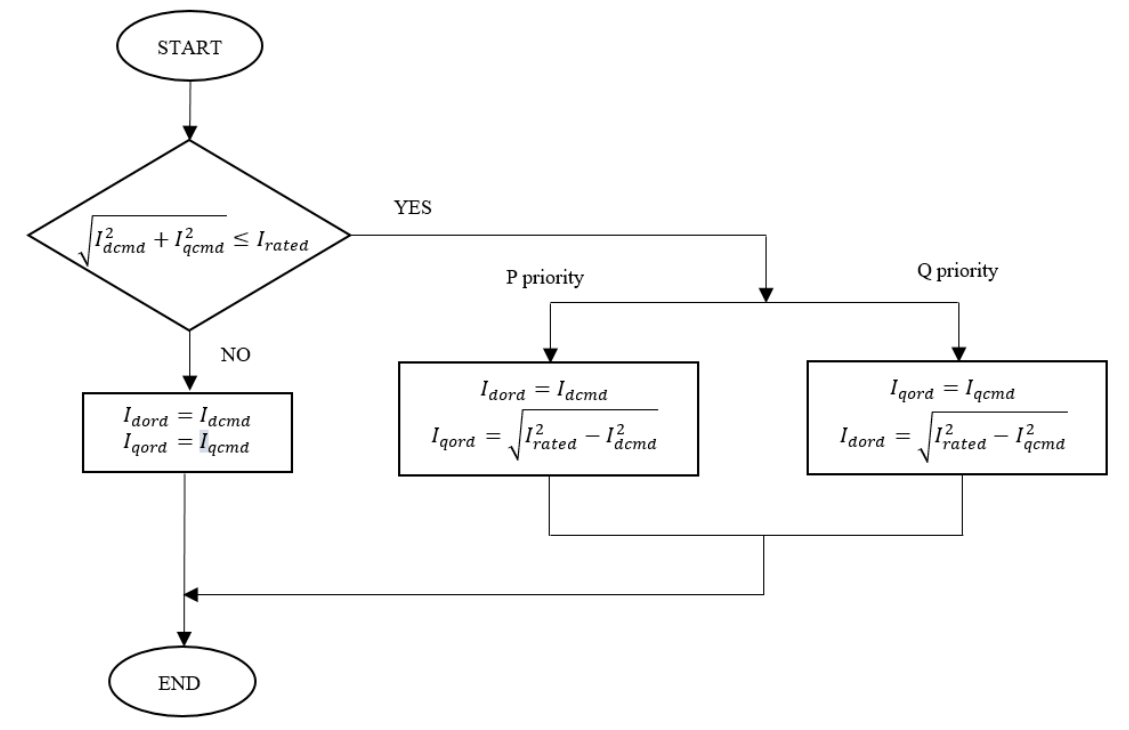
Figure A1. P , Q Priority algorithm.